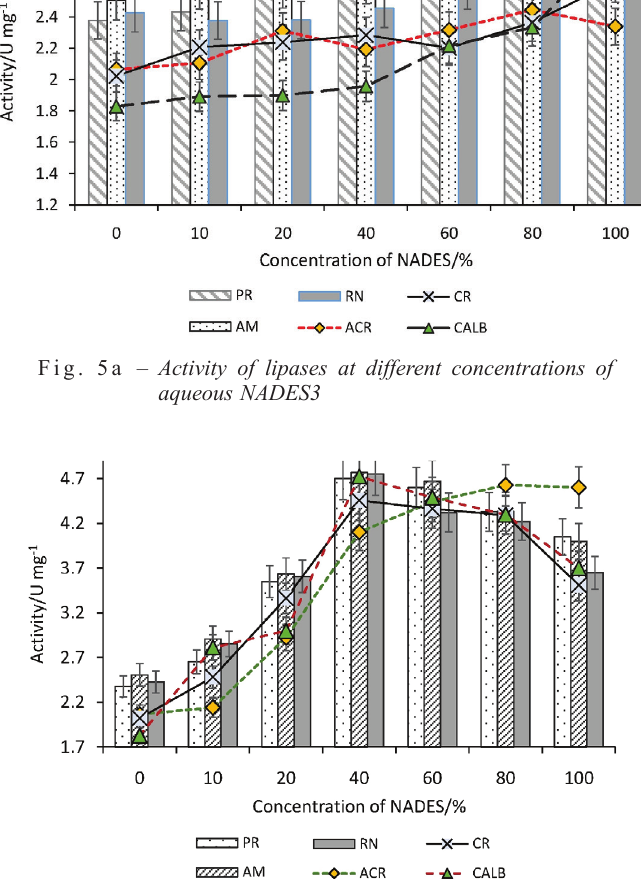
Fig. 5b – Activity of lipases at different concentrations of non-aqueous NADES3 (40 %). Lipase from porcine pancreas (PR), lipase from Candida rugosa (CR), Amano lipase PS, from Burkholderia cepacia (AM), lipase from Rhizopus niveus (RN), lipase acrylic resin from Candida antartica (ARC) (recombi- nant, expressed in Aspergillus niger), Lipase B Candida antar- tica immobilized on Immobead 150, recombinant from Asper- gillus oryzae